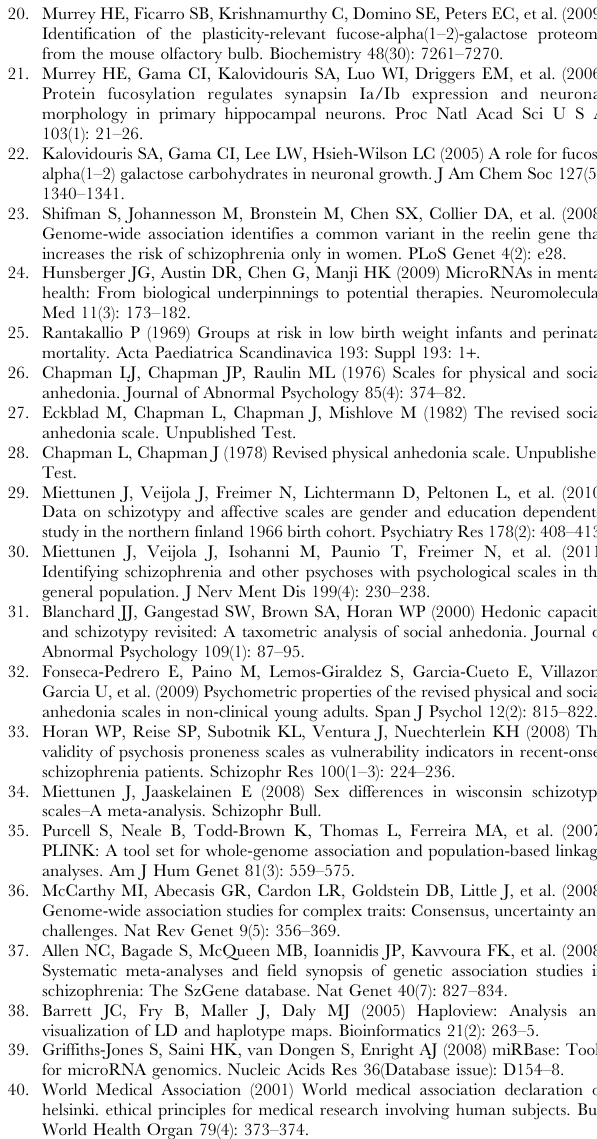
Table S3 Table of enriched IPA categories and func- tions for the gene targets of MIR620. Table S4 Table of enriched IPA categories and func- tions for the gene targets of